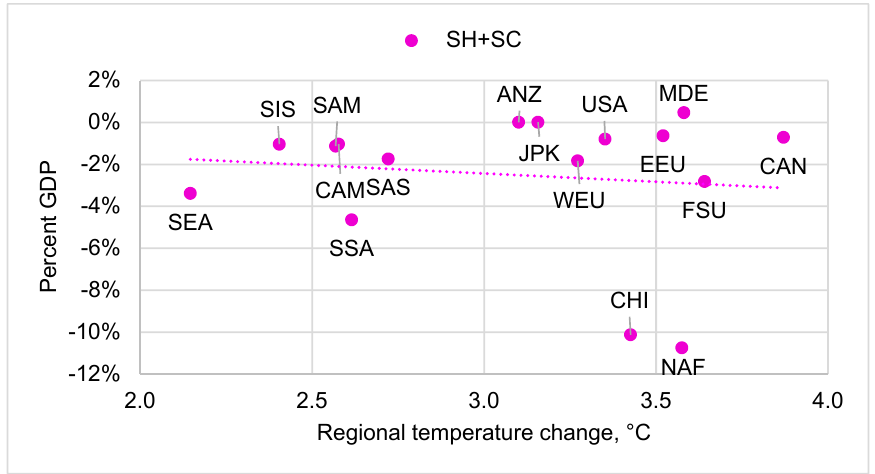
Figure 10. Economic impact of 3 ◦ C GMST increase on energy expenditure for FUND regions plotted against temperature change at the population centroid